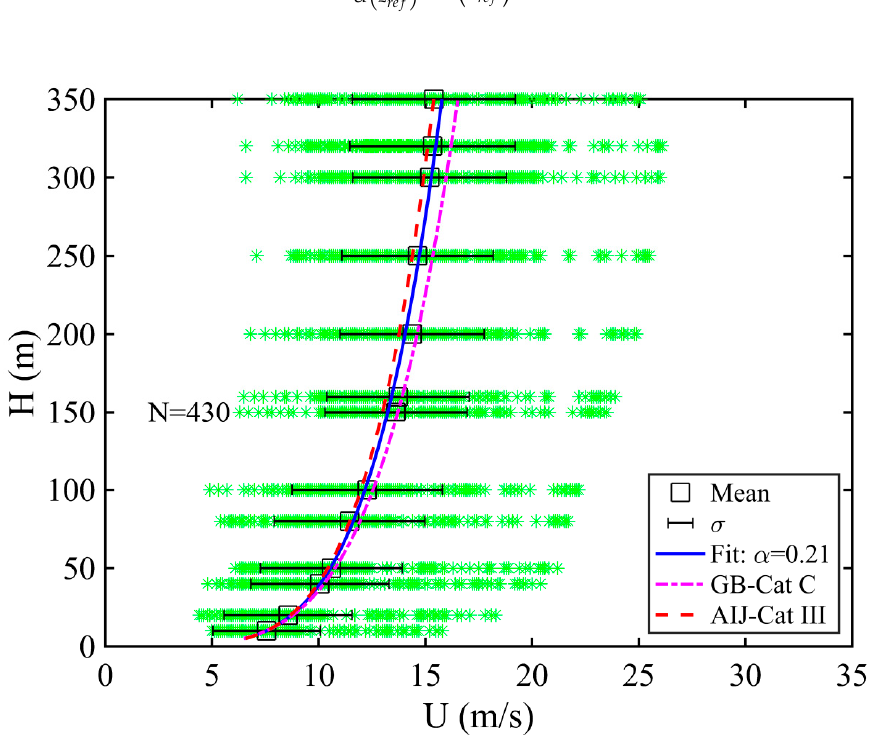
Figure 3. Ensemble mean wind profile of all 6 events. N is the number of individual profile members. Individual measurements (green dots), mean (black squares) and standard deviation (horizontal bars) are shown for each height bin. Power law fitting and empirical profiles are also shown.